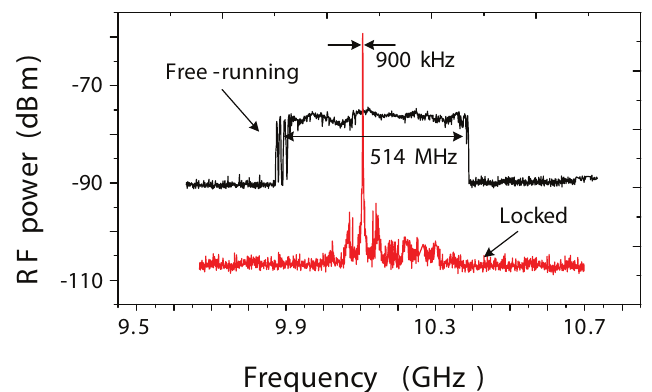
Figure 8. Measured frequency stability during a period of one minute with the MaxHold function of the